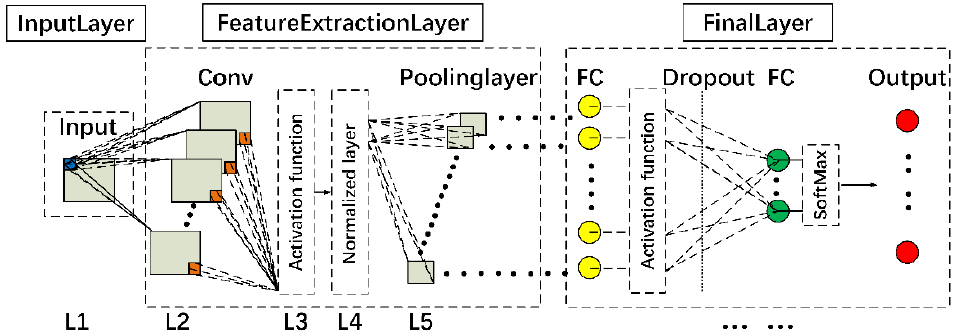
Figure 3. Overall structure of CNN.